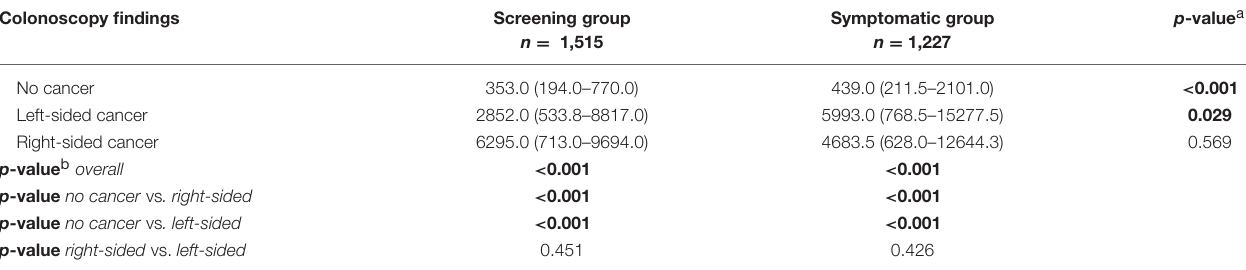
b Comparison between colonoscopy findings within each group. TABLE 6B | Hemoglobin FIT values according to colorectal cancer location (left- sided, right-sided). Colonoscopy